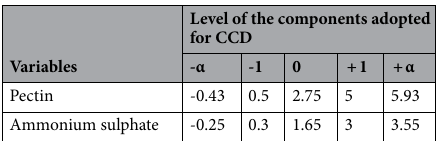
Table 2. Level of the significant media component chosen for the RSM-CCD